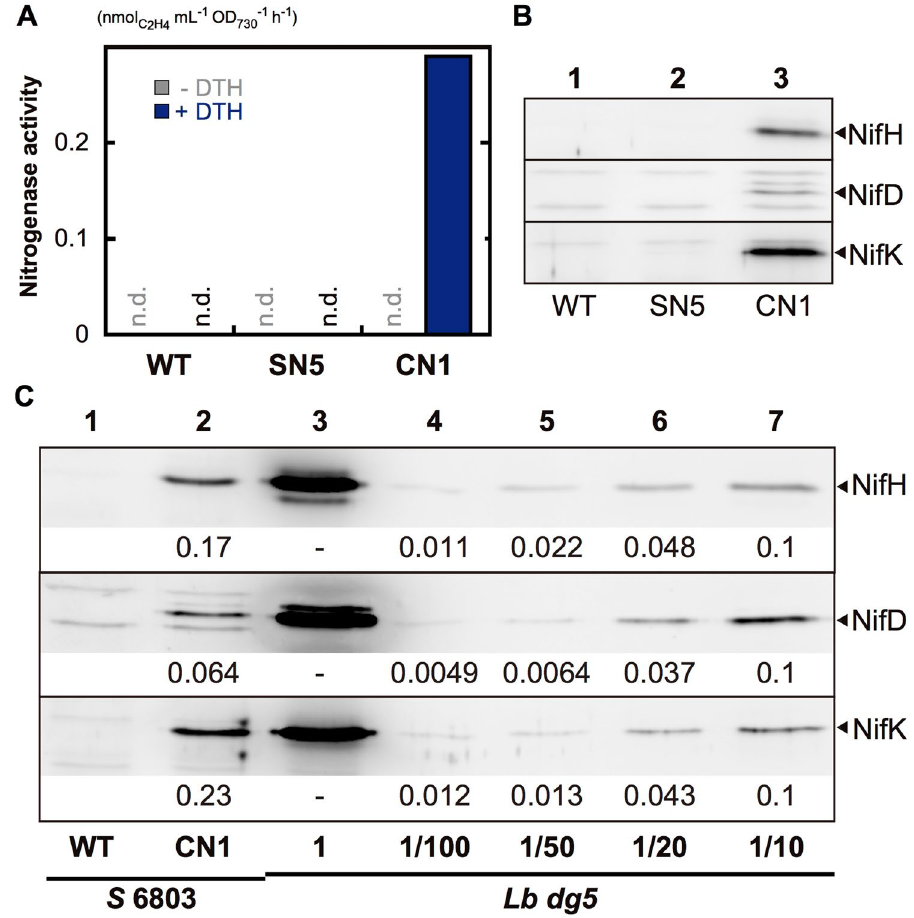
Figure 3. ( A ) Nitrogenase activity as measured by ethylene formation for WT, SN5, and CN1 Synechocystis 6803 in the presence (blue) and absence (gray) of dithionite. ( B ) Western blot analysis of crude extracts from WT (lane 1), SN5 (lane 2) and CN1 (lane 3) Synechocystis 6803 using antisera against NifH, NifD, and NifK. Five hundred nanograms of protein was loaded onto each lane. ( C ) Estimated expression levels of NifH, NifD, and NifK by CN1 (0.5 µ g, lane 2) compared to whole crude extract of L. boryana dg5 (0.5 µ g, lane 3) and serial dilutions (10-fold dilution, lane 7; 20-fold dilution, lane 6; 50-fold dilution, lane 5; and 100-fold dilution, lane 4). Numbers below the signals are relative band intensities estimated by densitometry normalized to 0.1 for the band in 10-fold dilution (ImageJ